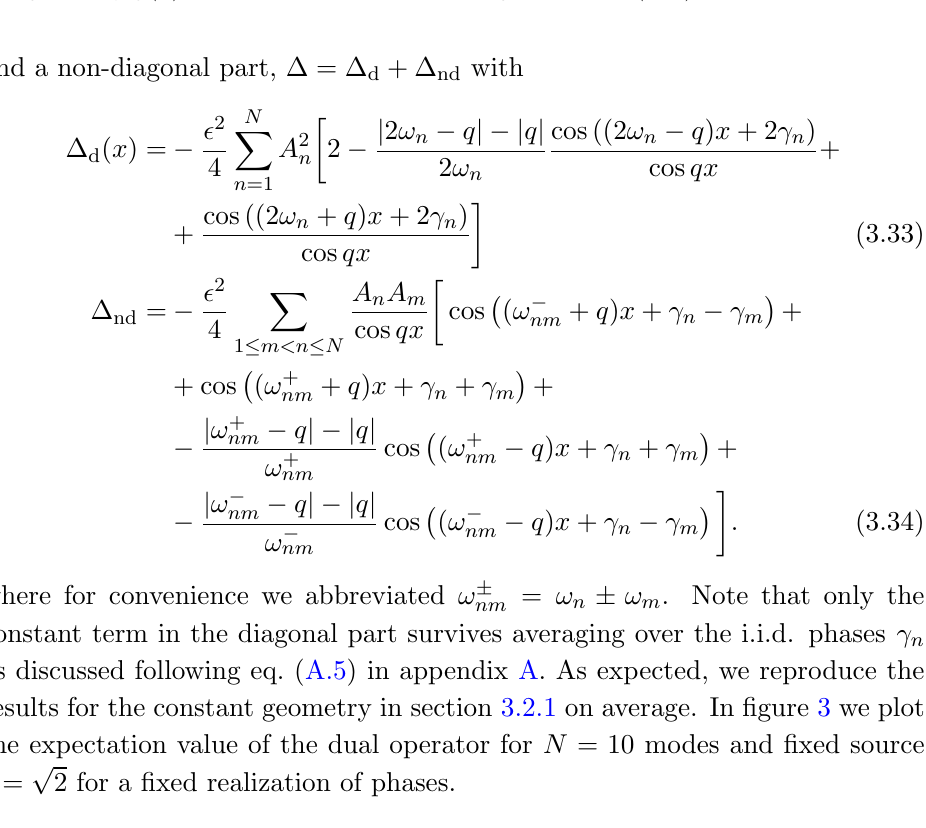
Figure 2 . Expectation value of the boundary operator O eq. (3.30) for source s ( x ) = cos qx and inhomogeneous geometry g ( x ) = cos !x with di(cid:11)erent con(cid:12)gurations of ( q; !